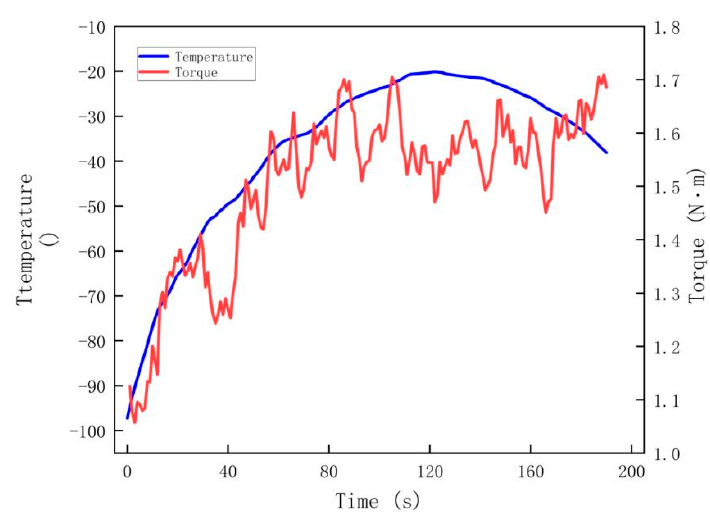
Figure 7. Torque and temperature curves of No. A2.